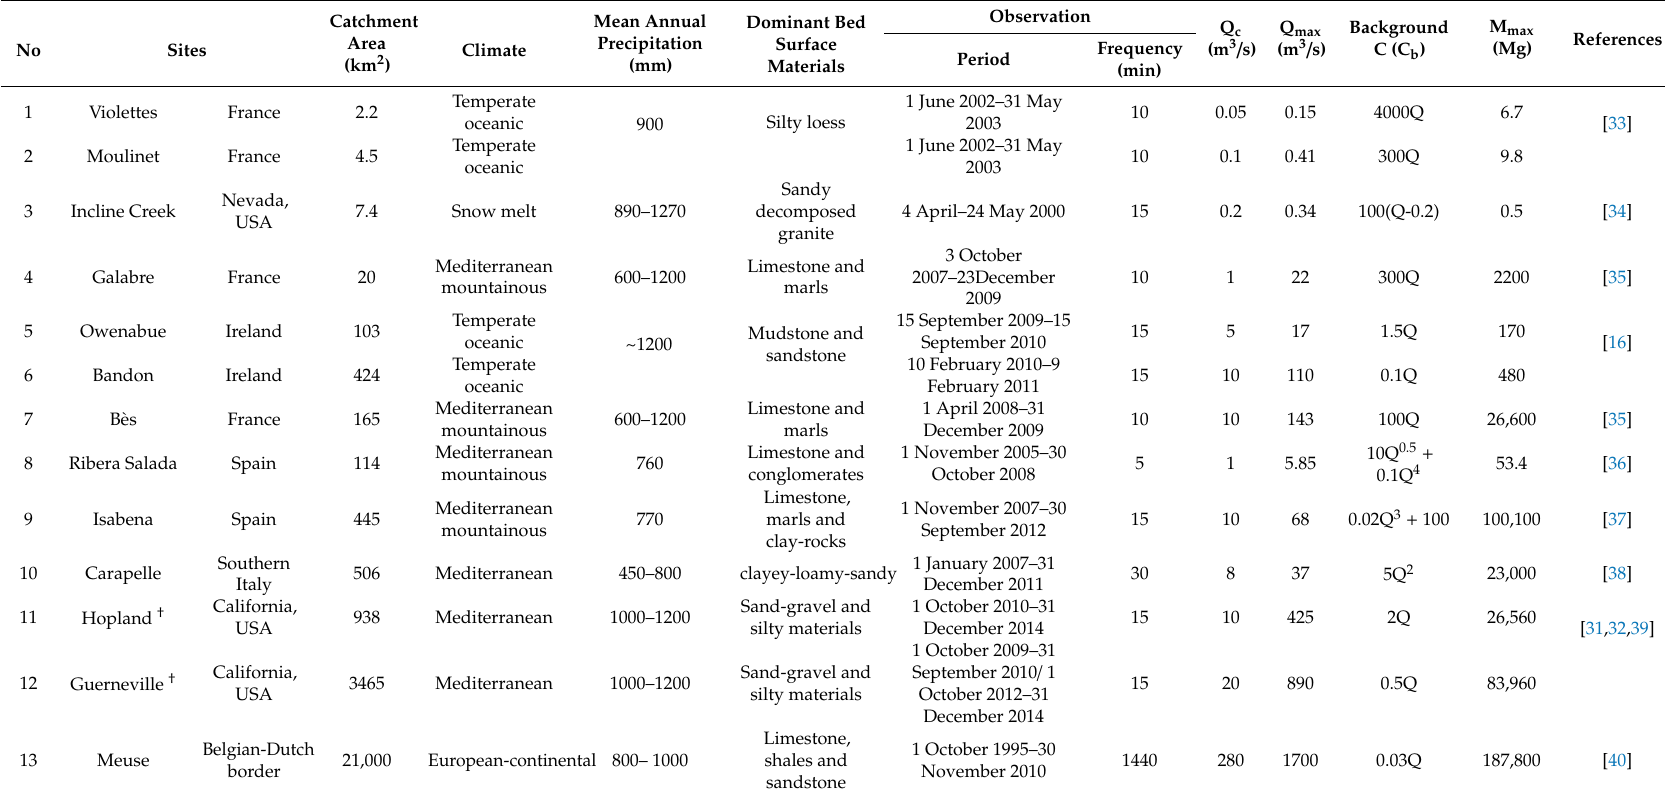
Table 1. Characteristics of the studied catchments and model